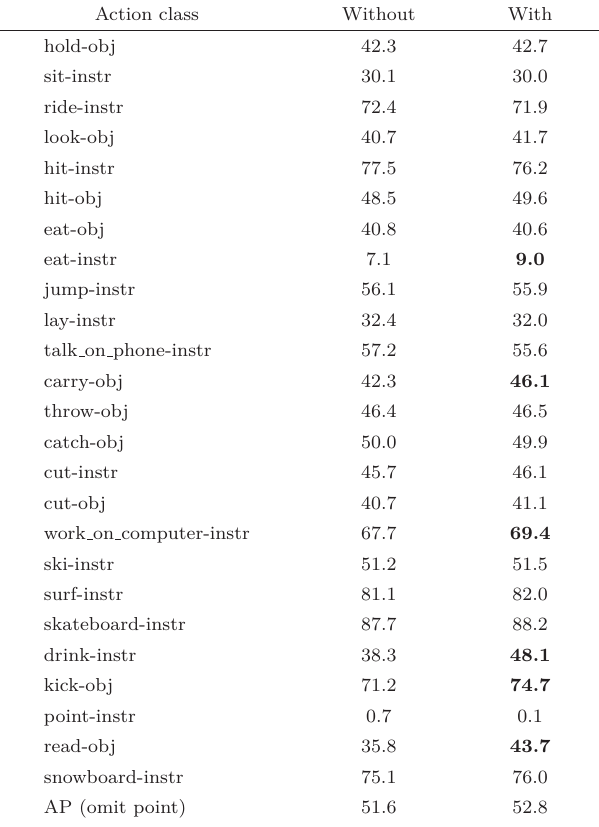
Table 4 Per-class performance with and without the semantic-level pairwise feature, for the V-COCO test set Action class